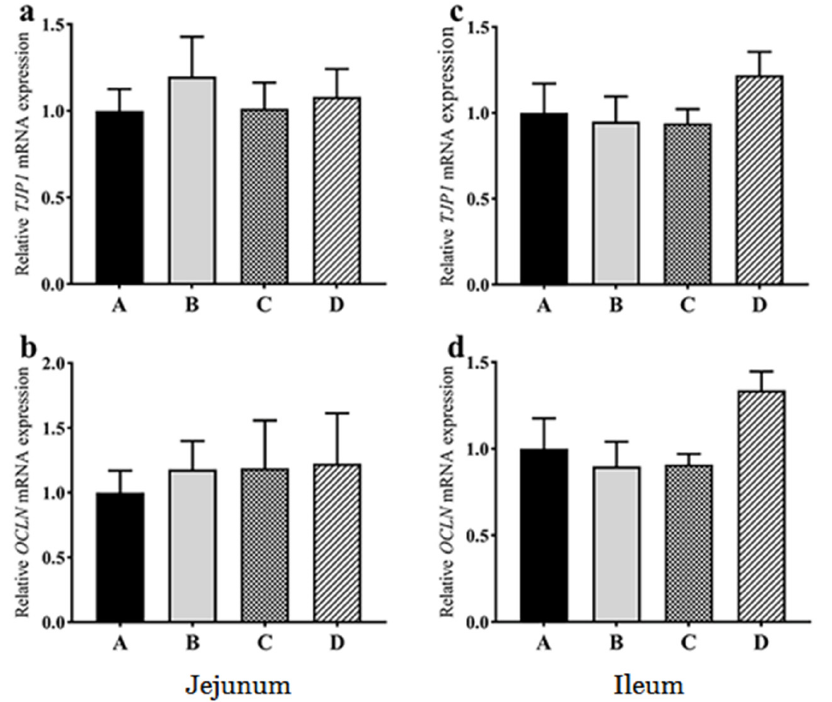
Figure 4. Effects of dietary probiotics on the mRNA expression levels of the tight junction-related genes in the jejunum ( a , b ) and ileum ( c , d ) of the geese at the age of 70 days. Note: a and c for TJP1 gene, b and d for OCLN gene. Group A (as control) was fed a basal diet, the treatment groups (B, C and D) were fed the basal diet supplemented with 250 mg/kg Clostridium butyricum (viable count 3.0 × 10 6 CFU/g), 250 mg/kg Bacillus subtilis (viable count 2.0 × 10 7 CFU/g), or the combination of 250 mg/kg Clostridium butyricum plus 250 mg/kg Bacillus subtilis , respectively. The relative mRNA transcript abundance of each gene was determined by quantitative PCR and presented as fold change over control group A. The internal control gene is GAPDH . n = 6. The data are presented as the mean ±